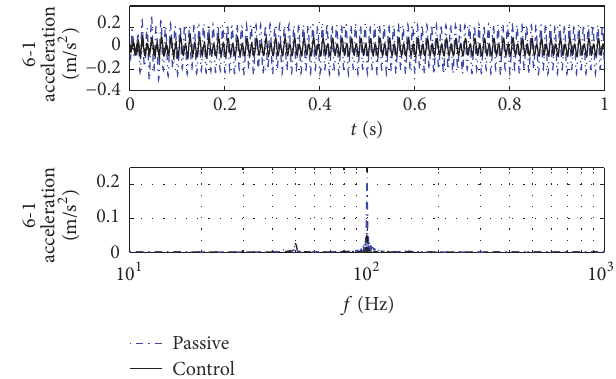
Figure 12: Comparison time-frequency domain curves of accelera- tion response of position 6-1 on the isolation system before and after being controlled under double sinusoidal